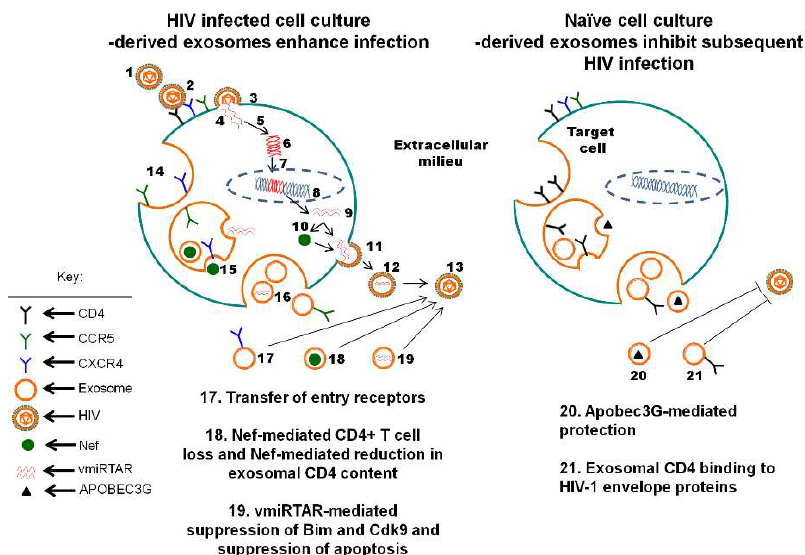
Figure 1. Cell culture derived exosomes modulate HIV-1 infection: ( 1 ) Cell-free